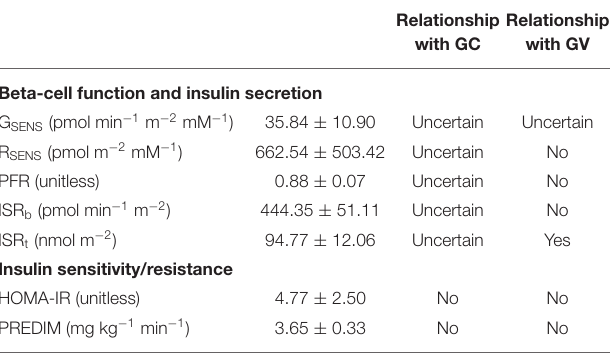
Relationship Relationship with GC with GV